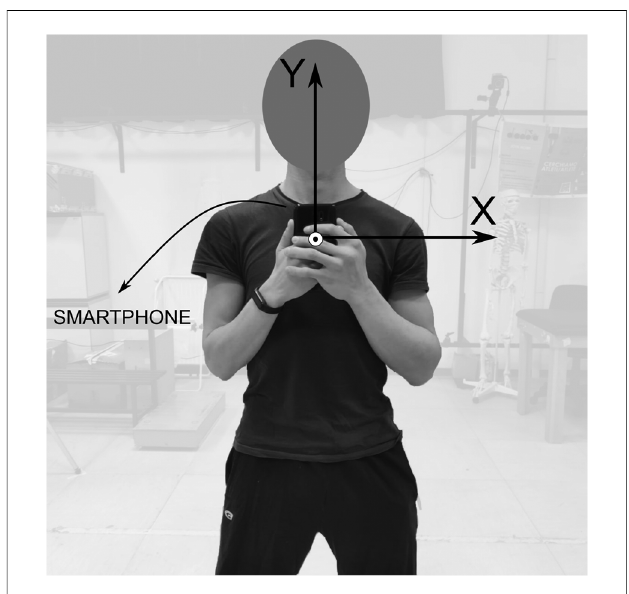
FIGURE 2 The experimental setup utilized for acquiring data from the SP device using the app Phyphox (remotely controlled via